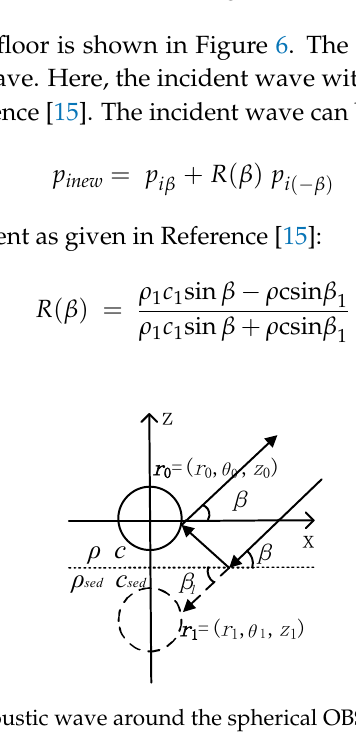
Figure 5. Incident and scattering acoustic waves of OBS.